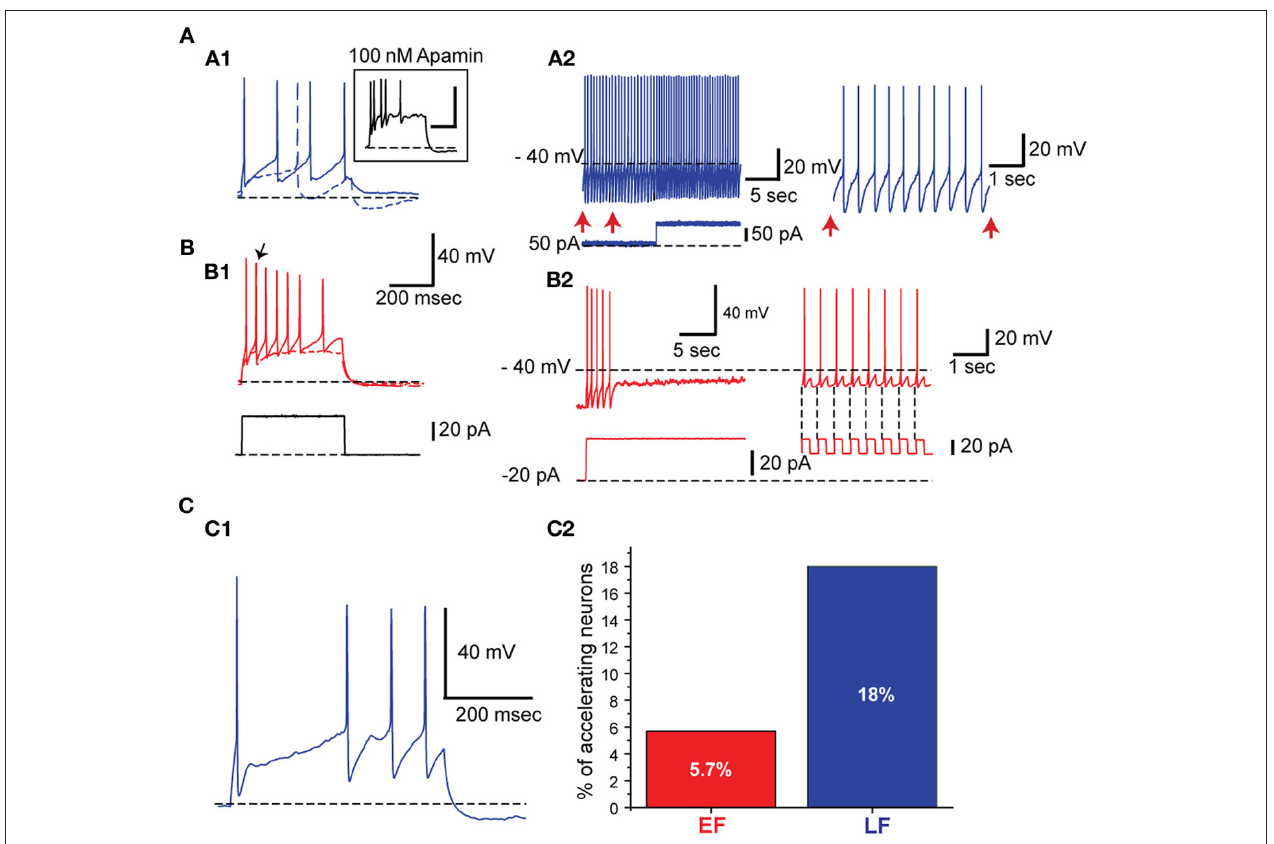
transiently in response to a sudden positive shift in the injected current. This is followed by irregular low frequency firing and complete silencing. When hyperpolarizing current pulses are superimposed ( B2 , right side ) on the positive background current, the neuron can sustain firing due to post inhibitory rebounds (see the vertical dashed lines at the ends of negative current pulses shown below). (C) Spike frequency acceleration. (C1) Example of an LF neuron exhibiting spike frequency acceleration. (C2) Percentage of neurons with spike frequency